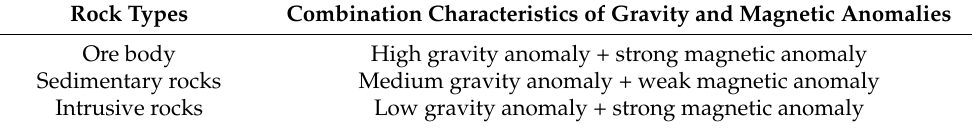
Table 3. The combination characteristics of gravity and magnetic anomalies of different rocks in the study